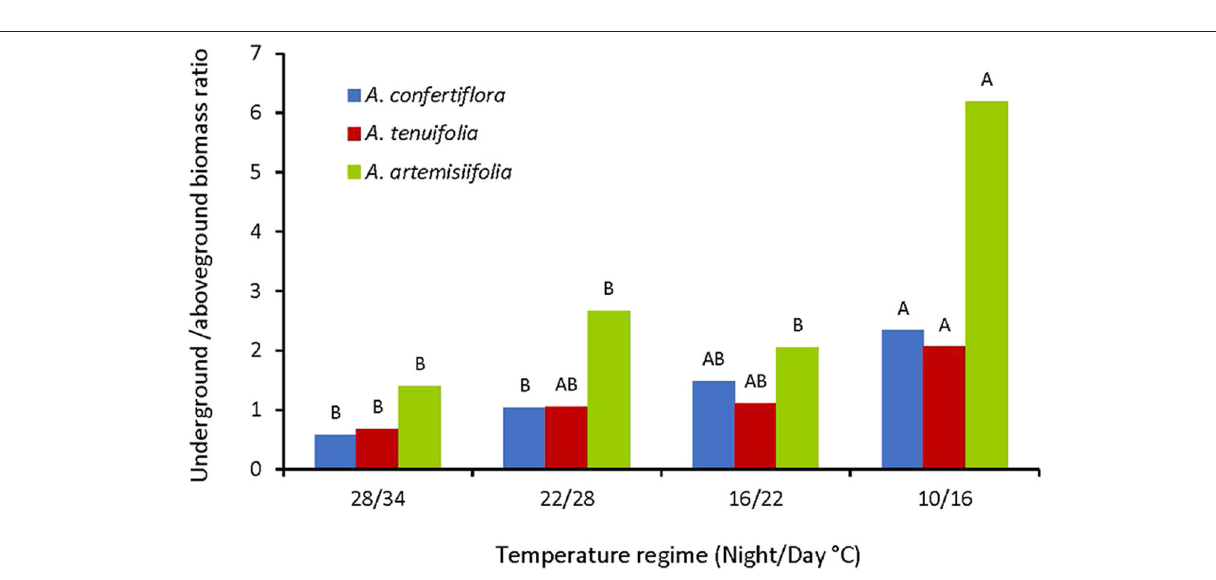
sprouts first emerged from soil 25 DAS in both